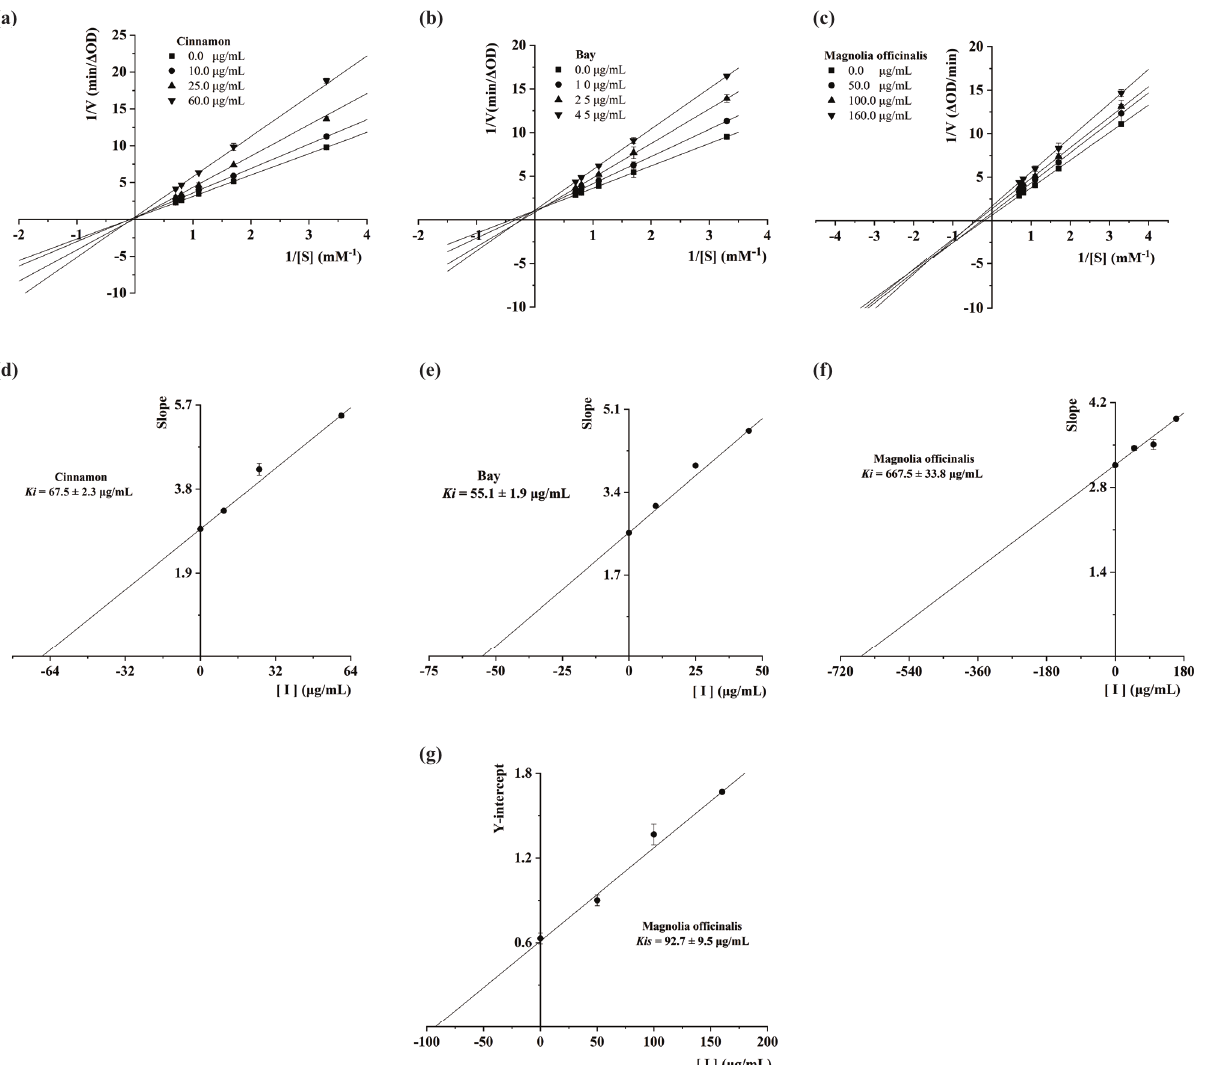
Fig. 2. Lineweaver-Burk plots (a, b, and c) for cinnamon, bay, and magnolia officinalis against tyrosinase. (d, e, and f) The plot of slope versus the concentration of cinnamon, bay, and magnolia officinalis for the determination of K versus the concentration of magnolia officinalis for the determination of K